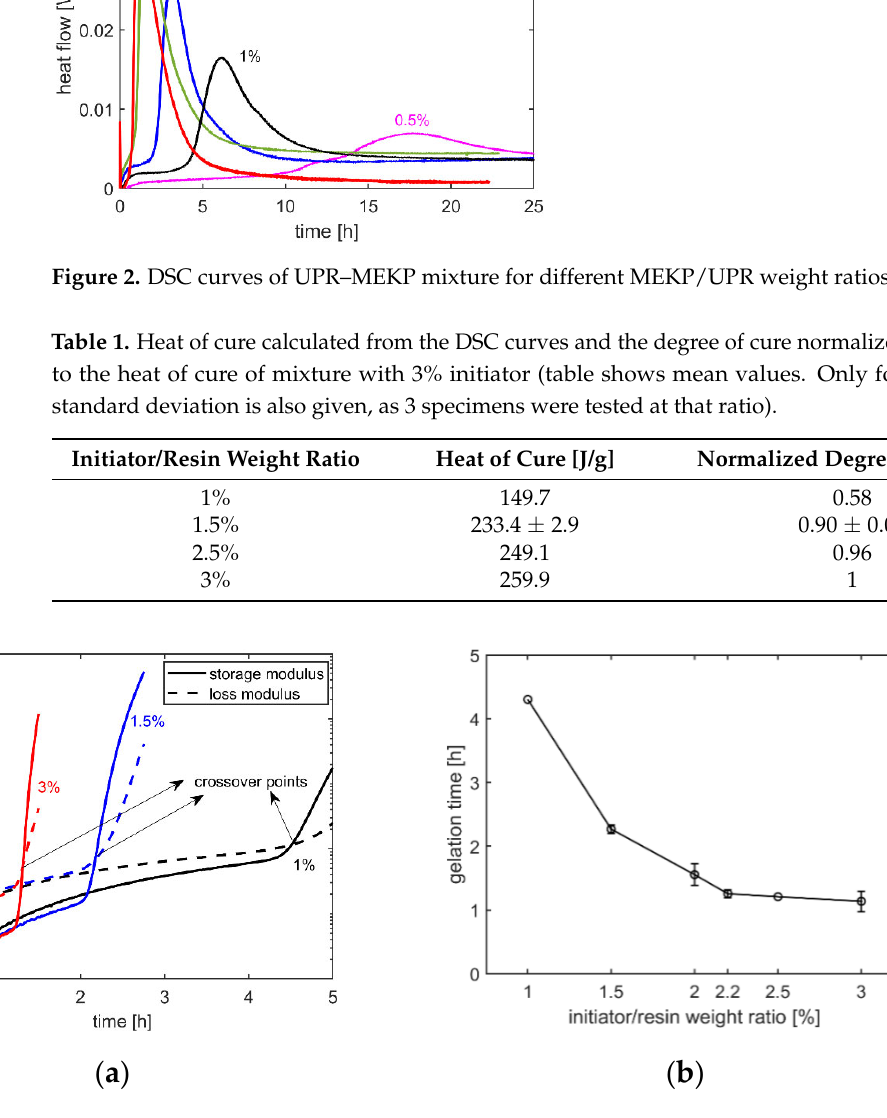
Figure 3. ( a ) The evolution of storage and loss modulus with time in rheometer tests and ( b ) gelation times of UPR ‐ MEKP mixture for different MEKP/UPR weight ratios. Markers represent mean values and error bars represent ± one standard deviation (no error bar at 1% and 2.5%, since only 2 speci ‐ mens were tested at these ratios).